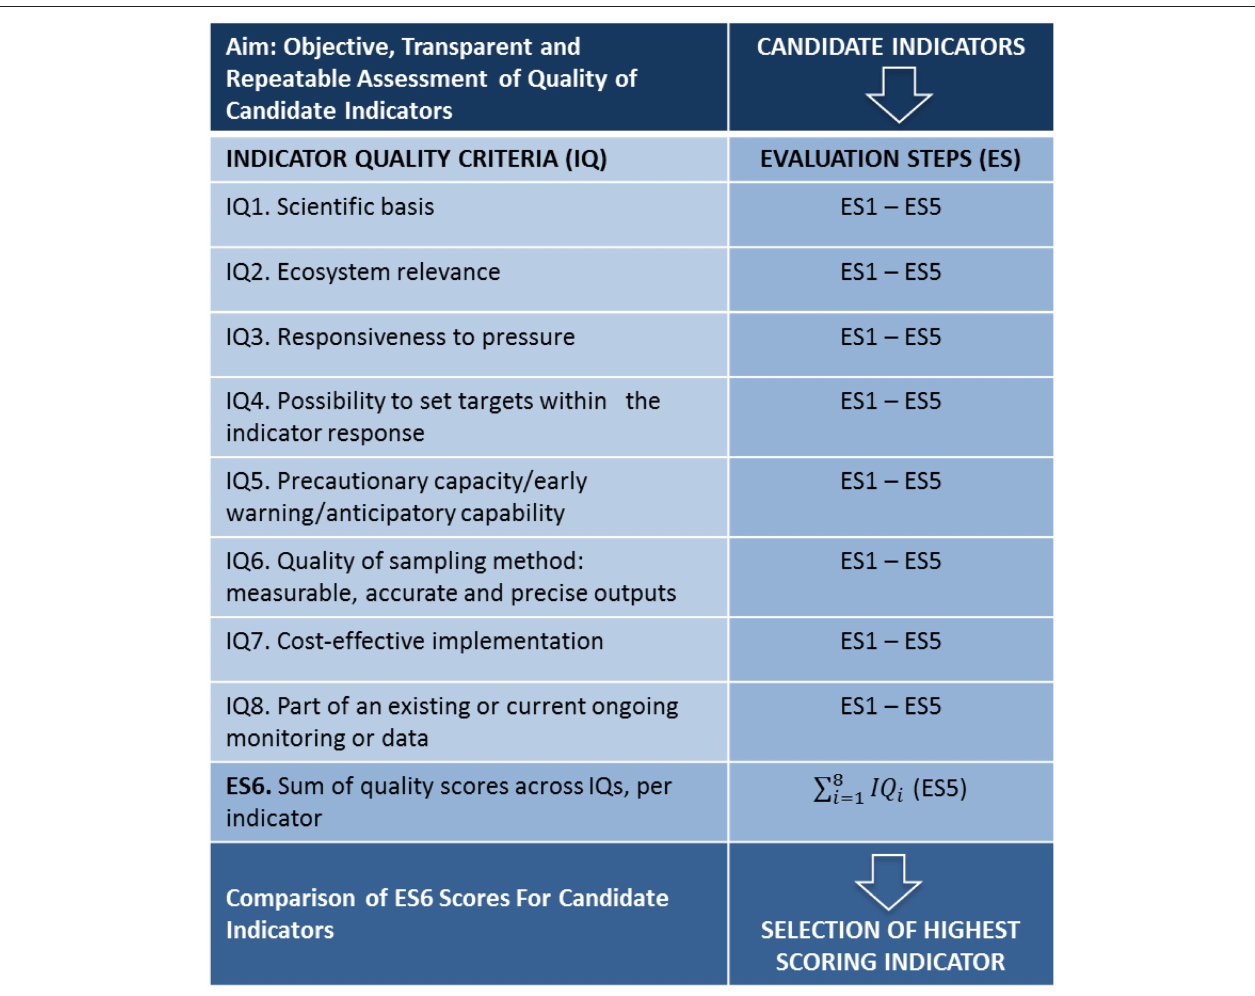
FIGURE 1 | Overview of the elements in the IQ-ES framework for candidate indicator selection. Candidate indicators are tested on the basis of eight indicator quality criteria (IQ1–IQ8), each of which are evaluated and scored through five sequential steps (ES1–ES5). The final score for each candidate indicator is calculated across IQ1–IQ8 in evaluation step 6 (ES6). The comparison of the total quality score of candidate indicators is intended to provide an objective and transparent basis to inform indicator